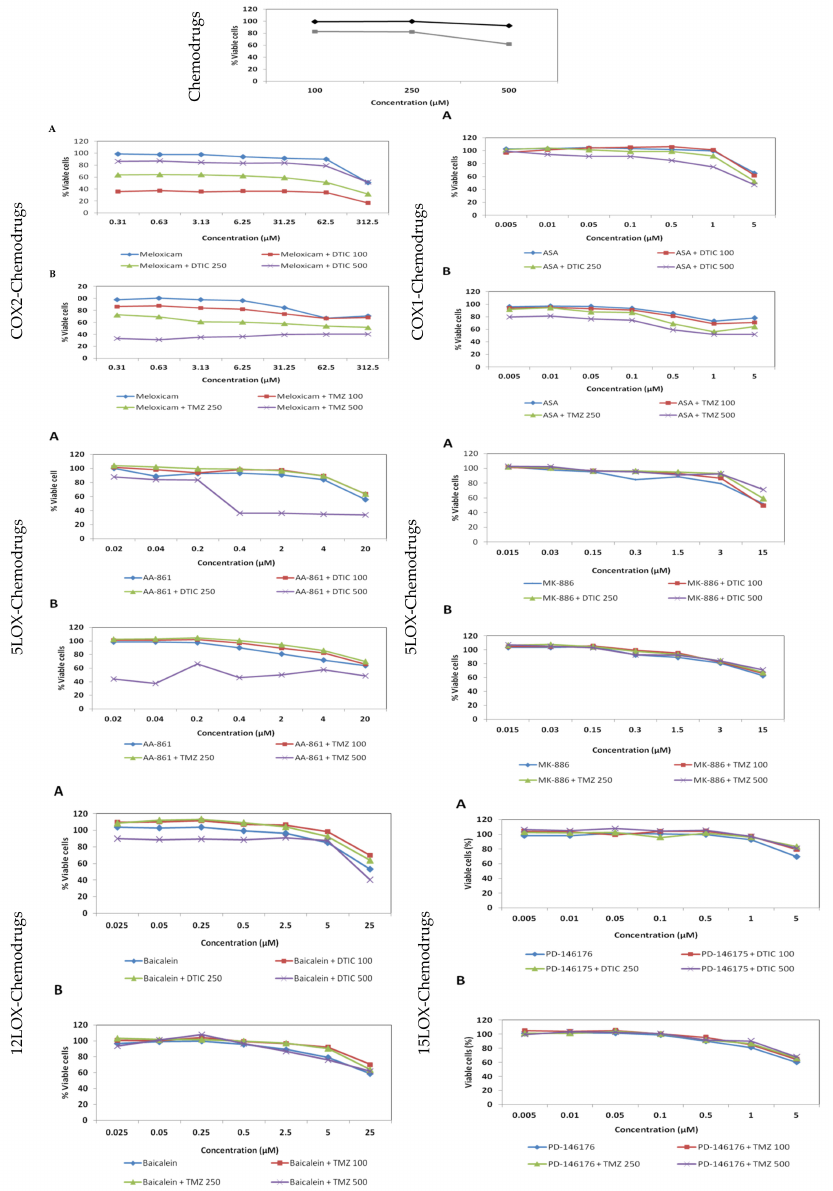
Figure 11. Dose response curves of ( A ) Combination treatment inhibitor + dacarbazine (100, 250 and 500 µ M). ( B ) Combination treatment inhibitor + temozolomide (100, 250 and 500 µ M). The y axis shows the percentage of viable cells after 72 h and the x axis the different concentrations ( µ M) of